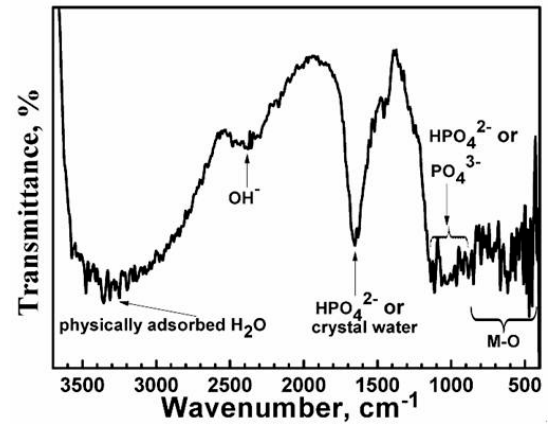
Figure 2. FTIR spectrum of the film.